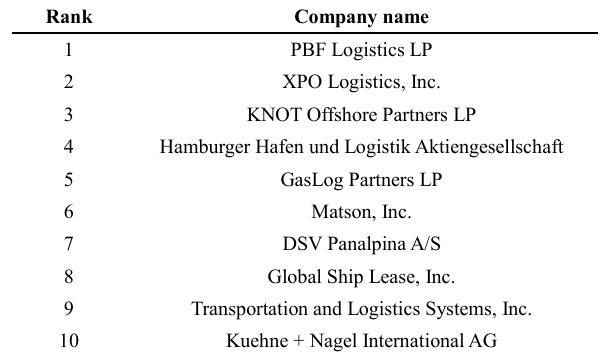
Table 3. The main information transmitter equities, after COVID-19